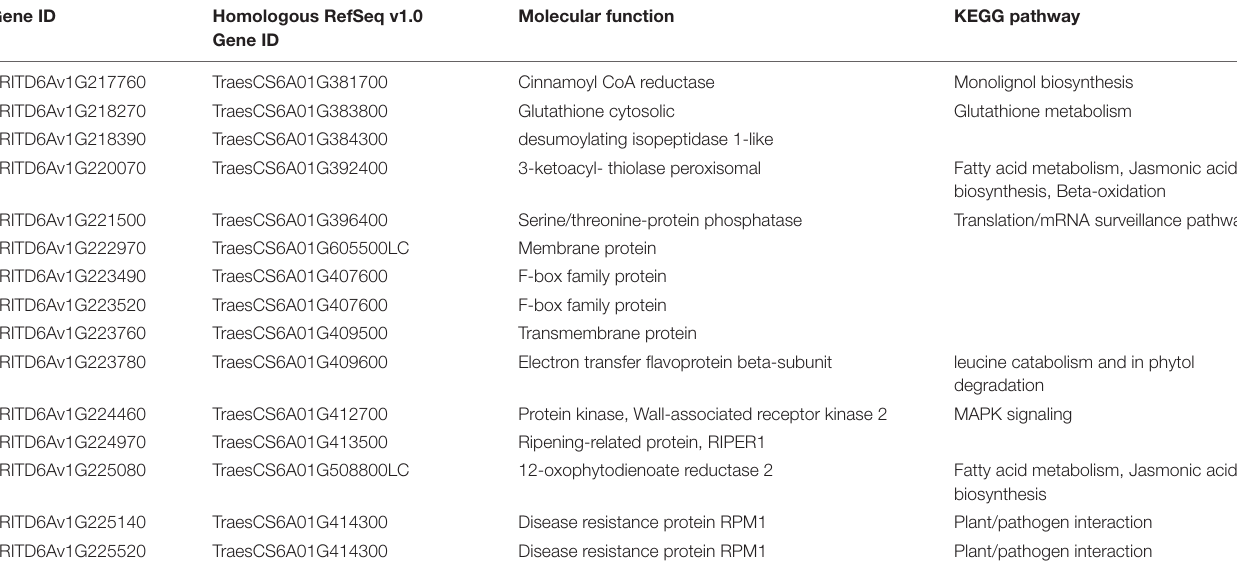
TABLE 2 | List of 15 candidate genes identified using the homologous chromosome 6A genomic region of bread wheat through functional analysis of qSRA-6A. Gene ID Homologous RefSeq v1.0 Gene